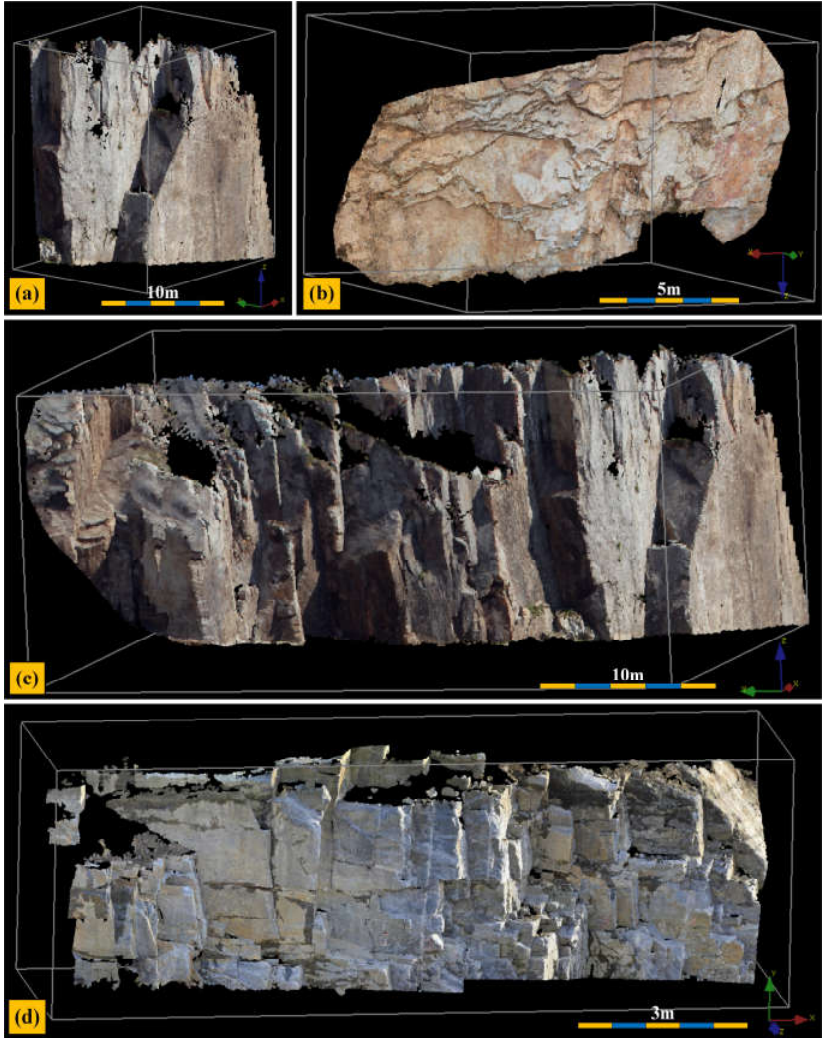
Figure 2. Point cloud datasets. ( a ) Example case; ( b ) Case A; ( c ) Case B; ( d ) Case C.